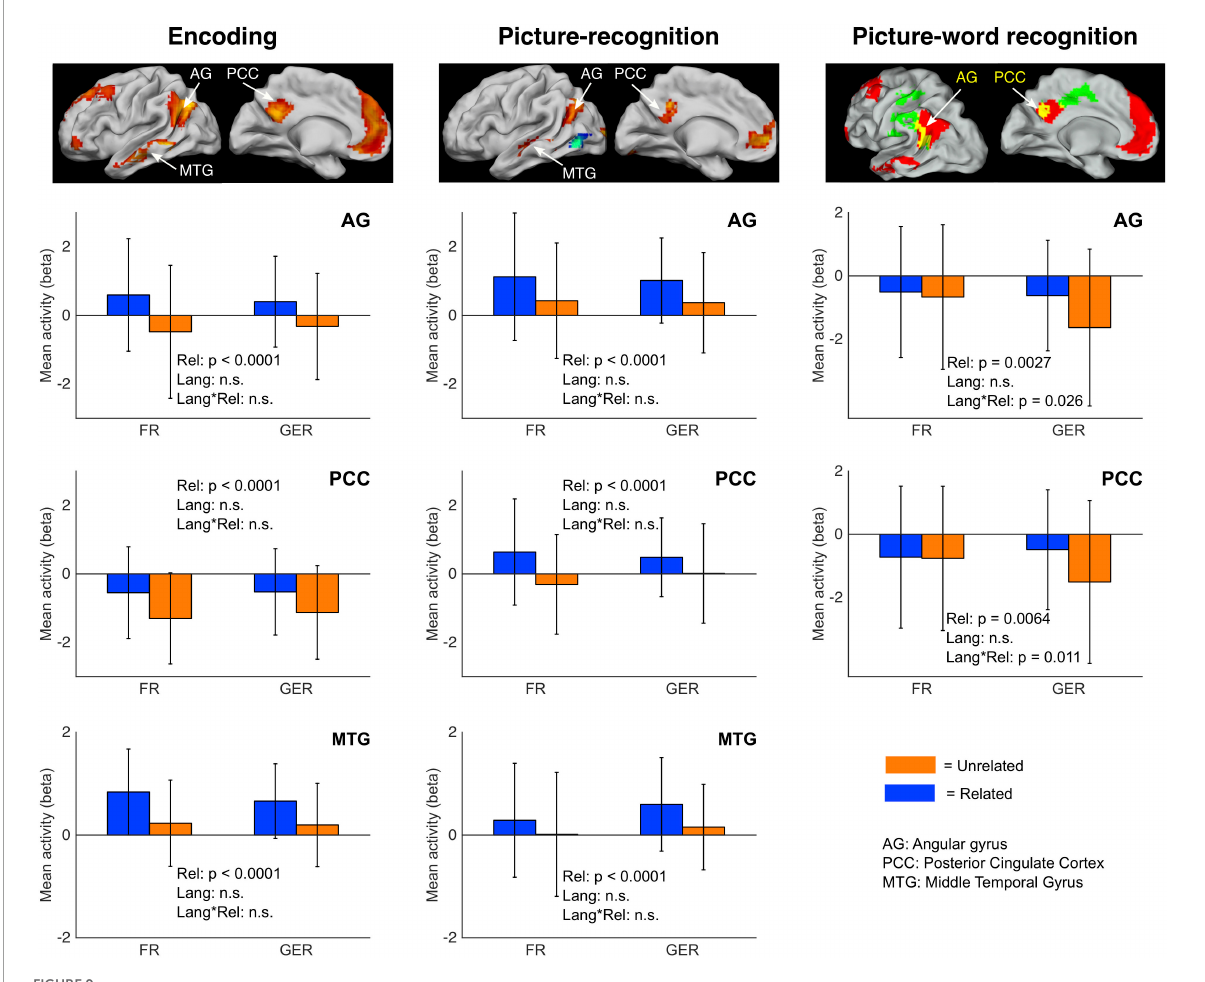
FIGURE9 Modulation of semantic congruency effects on neural activity by language. Barplots of mean regional activity during encoding (left column), Picture-recognition (middle column) and picture-word recognition (right column) based on relatedness [ Related , Unrelated ] (abbreviated as Rel) and Language [FR, GER] (abbreviated as Lang). Regions of interest (ROIs) were selected from the group-level Related > Unrelated contrasts (encoding: Figure 3B ; picture-recognition: Figure 4C ; picture-word recognition: Figure 7 , yellow areas indicating overlap). Error bars indicate the standard deviation. n.s. = not significant ( p > 0.05, exact p-values are listed in Table 6